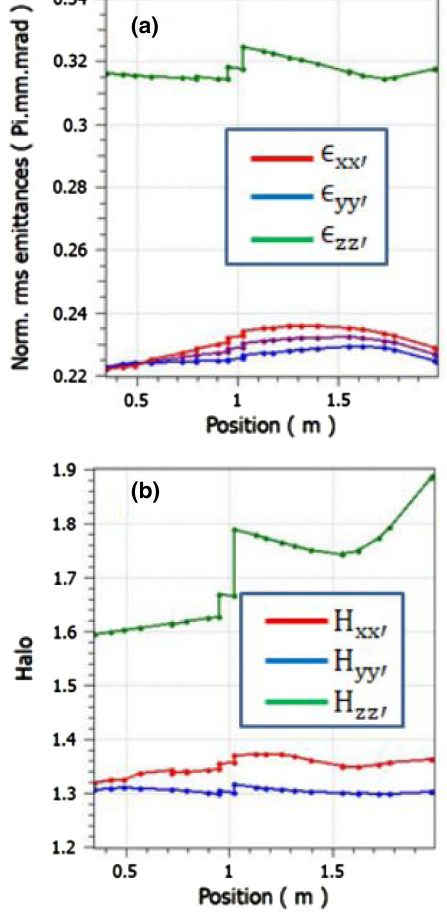
FIG. 13. (a) RMS normalized transverse and longitudinal emittance along MEBT, and (b) Transverse and longitudinal beam halo parameter along